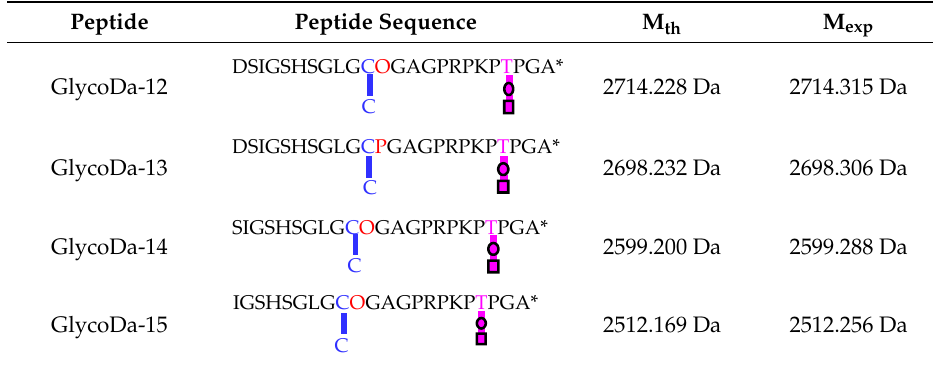
Table 3. Isoforms of GlycoDa-12—O: 4- trans -hydroxyproline; * : amidation at C-terminal extremity. Peptide Sequence